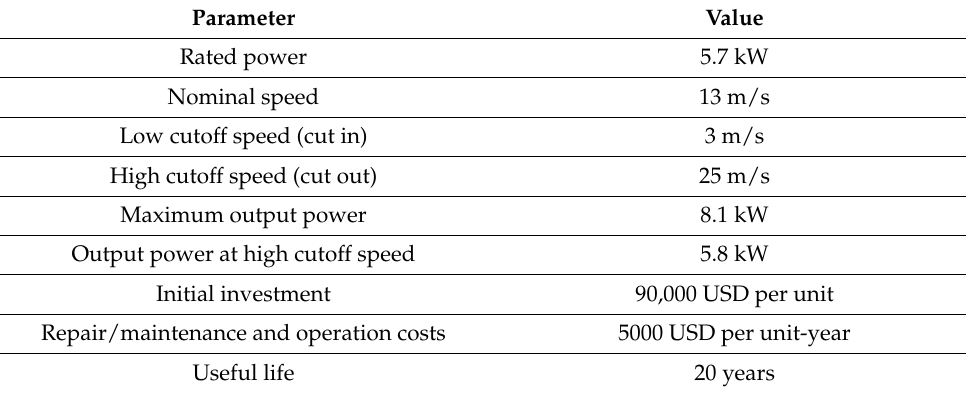
Table 2. Wind turbine parameters.